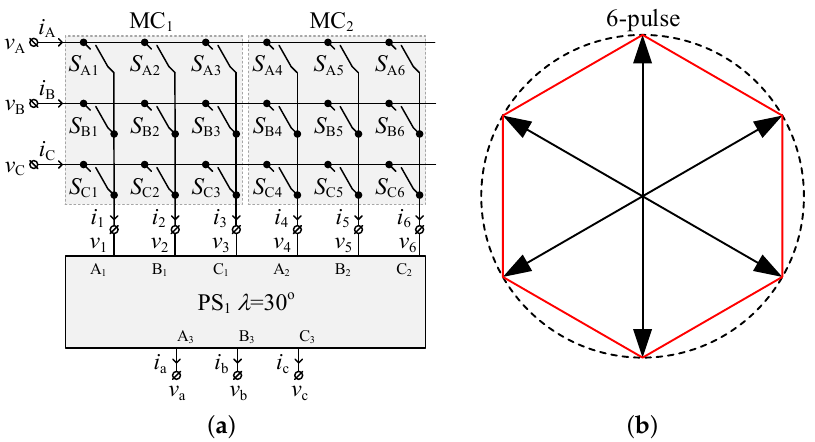
Figure 5. Two conventional matrix converters make the 6-pulse system: ( a ) schematic diagram, ( b ) the voltages discrete projection.